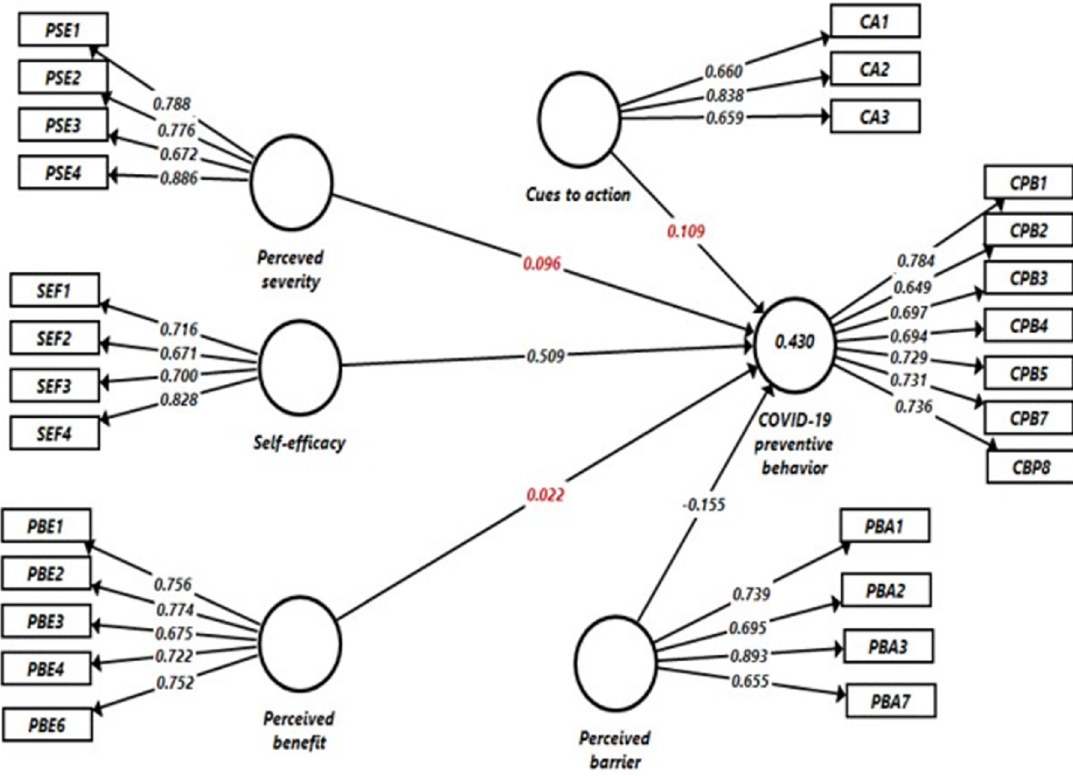
Fig 1. Structural equation model of determinants of CPB among secondary school students in Gondar city, Northwest Ethiopia, 2020. CA = Cues to action, CBM = COVID-19 preventive behaviors, PBA = Perceived barrier, PBE = Perceived benefit, PSE = Perceived severity, SEF = Self efficacy, Path coefficients shown in red color were not statistically significant.